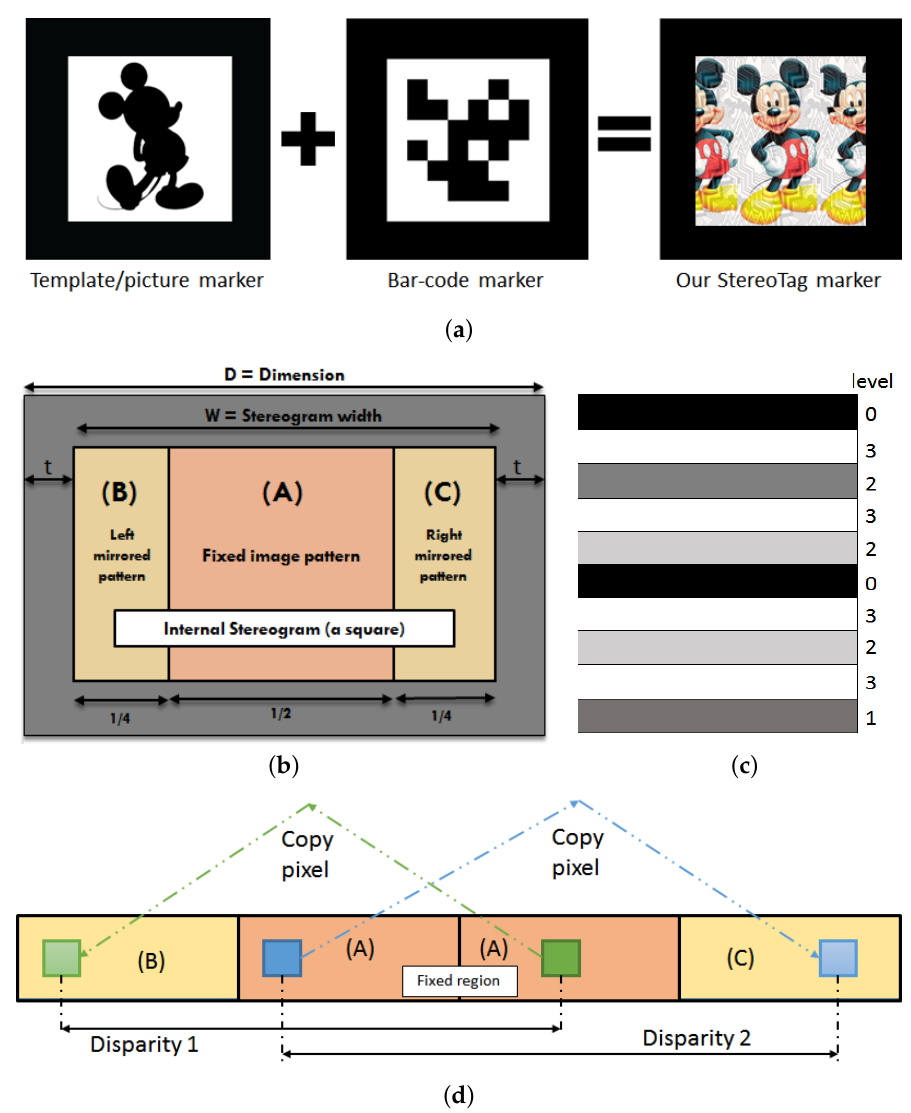
Figure 6. Design of Pictorial Marker with Hidden 3D Bar-Code (PMBC) tag that optically hides a multi-level bar-code. ( a ) idea of our Pictorial Marker.; ( b ) design of proposed PMBC Tag.; ( c ) multi-level bar-code.; ( d ) principle of the tag